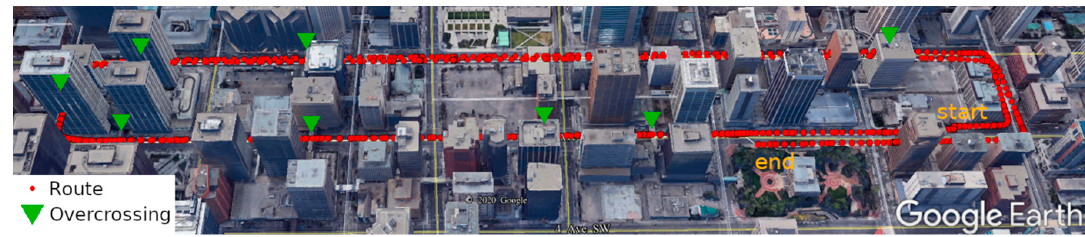
Table 1. Parameter values used in the weight scheme. Figure 3. Google Earth view of field test 1. Figure 3. Google Earth view of field test